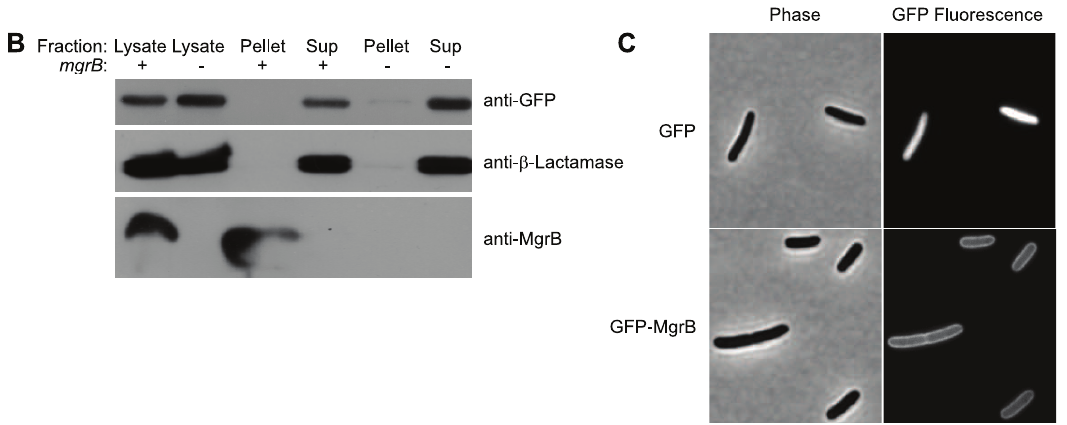
Figure 3. MgrB localizes to the inner membrane invivo . (A) The amino acid sequence of MgrB. The underlined region is a potential transmembrane domain [36]. The arrows labeled I and II denote potential type I ([34] ) and type II [35] signal sequence cleavage sites, respectively. (B) Western blot of the total cell lysate, envelope fraction (pellet), or the soluble protein fraction (sup), of an mgrB 2 strain expressing cytoplasmic YFP and CFP (AML20) and containing either a control plasmid (pEB52) or an mgrB expression plasmid (pAL8). Both plasmids also express beta-lactamase, an enzyme that resides in the periplasm. (C) Phase contrast and GFP fluorescence micrographs of AML67 ( mgrB 2 ) expressing either GFP (pAL39, top) or a fusion of GFP to the N-terminus of MgrB (pAL38, bottom). Cells were grown in minimal glucose medium with 1 mM MgSO 4 .